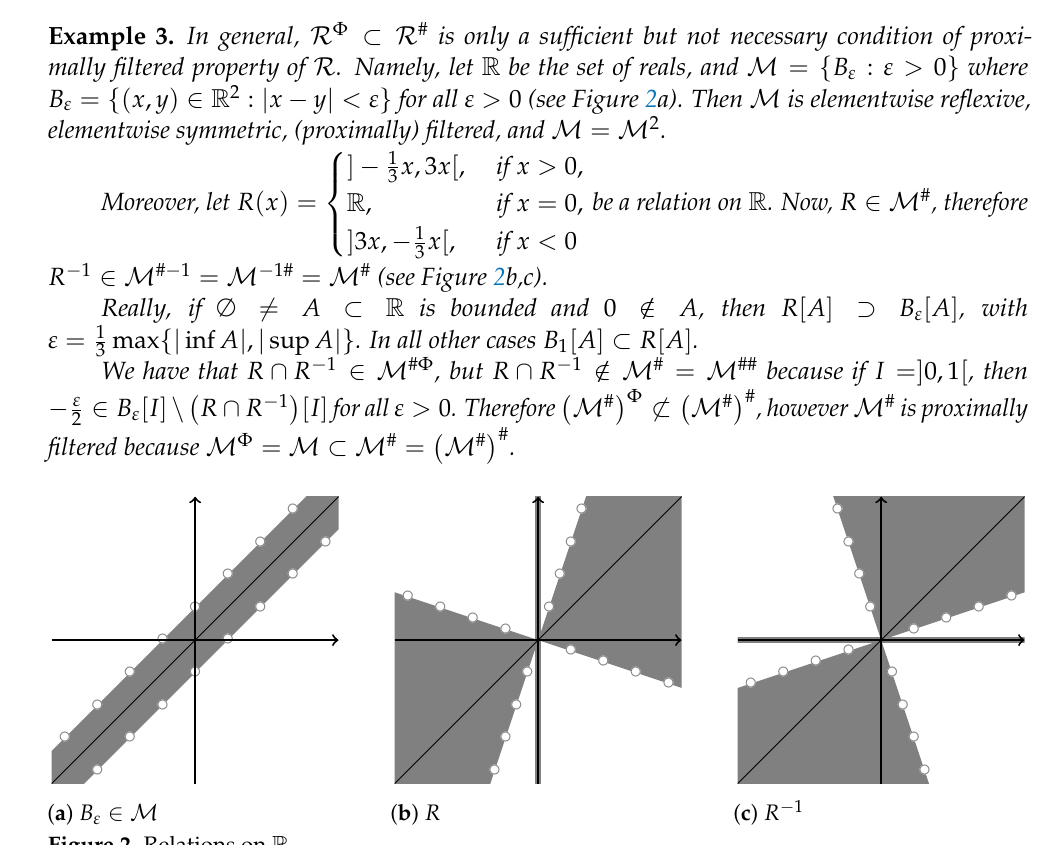
Figure 2. Relations on R